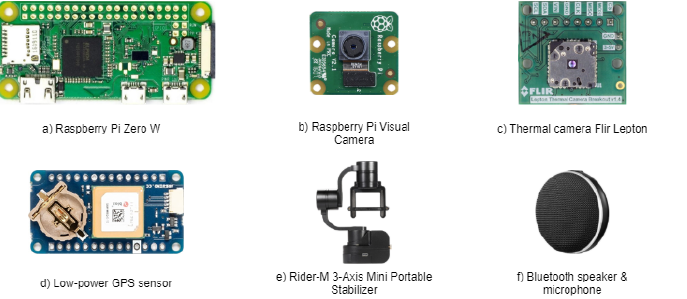
Figure 6. The K9 Vest